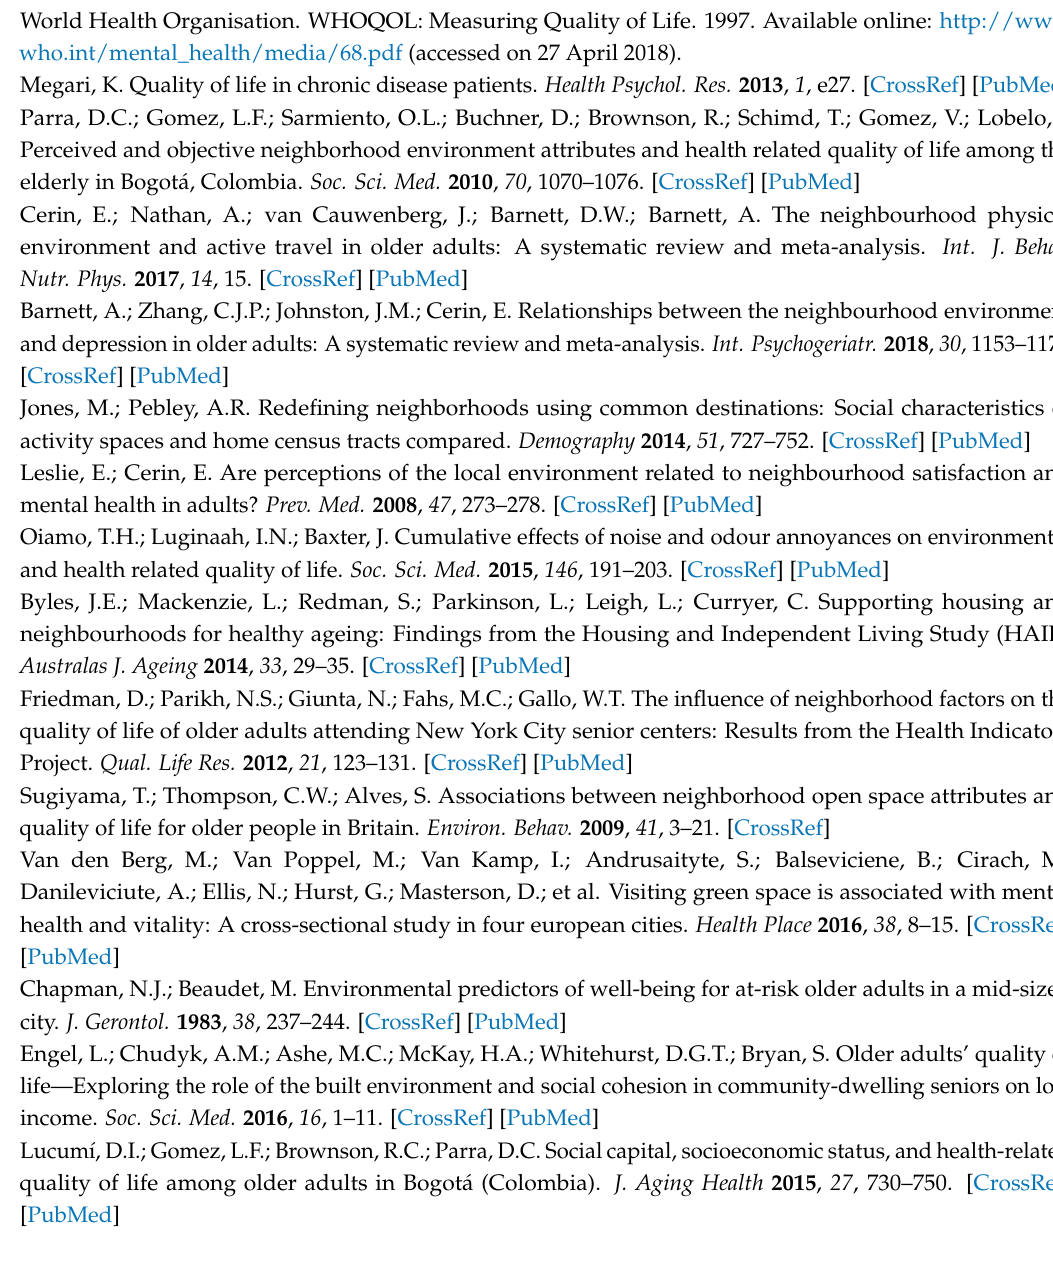
Definitions of environmental variables and expected associations with quality of life (QoL), Table S2: Associations of socio-demographic and health-related characteristics with quality of life (QoL) domains, Table S3: Associations between single GIS neighbourhood environmental attributes based on 400 m street-network buffers and quality of life (QoL)